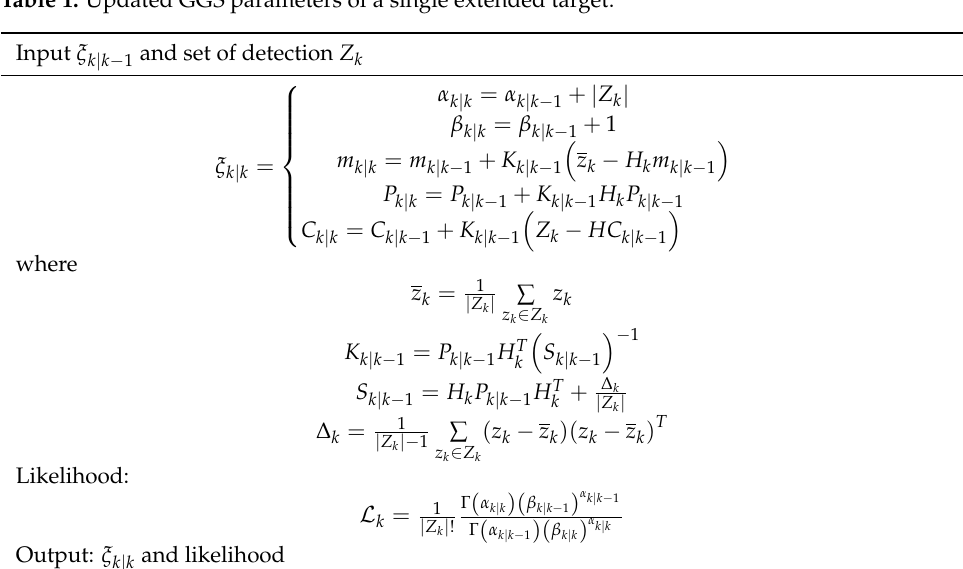
Figure 6. The pipeline of the proposed algorithm. Table 1. Updated GGS parameters of a single extended target.